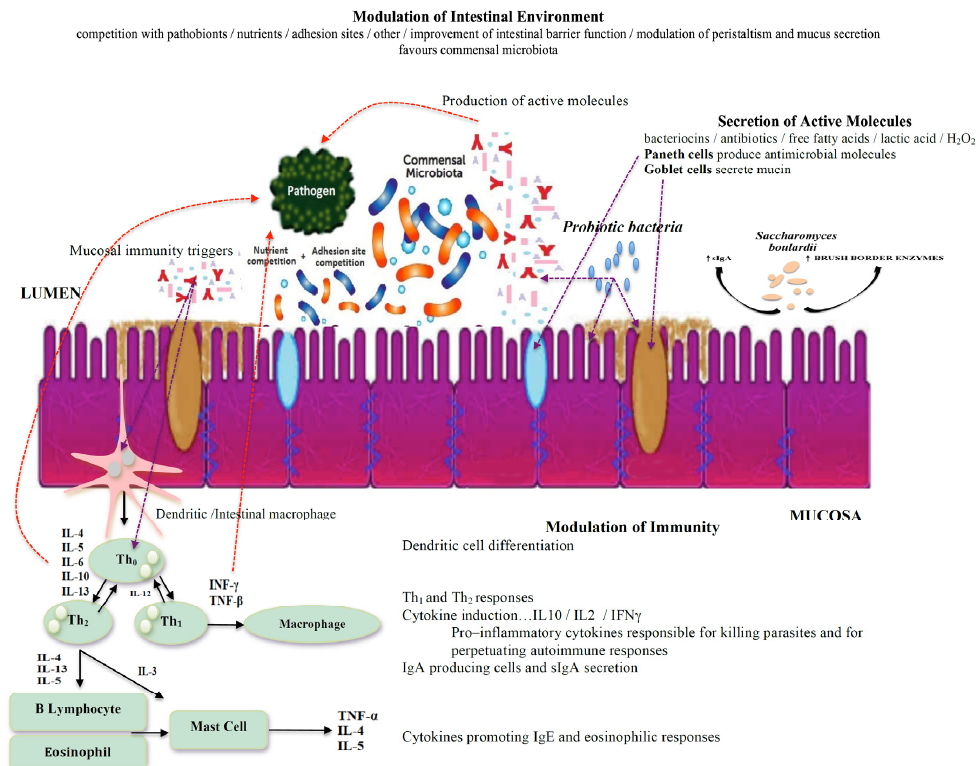
Figure 1. Schematic presentation of commensal, pathobiont, probiotic bacteria, and yeast interactions in the intestines with the production of antimicrobial compounds. Adapted from